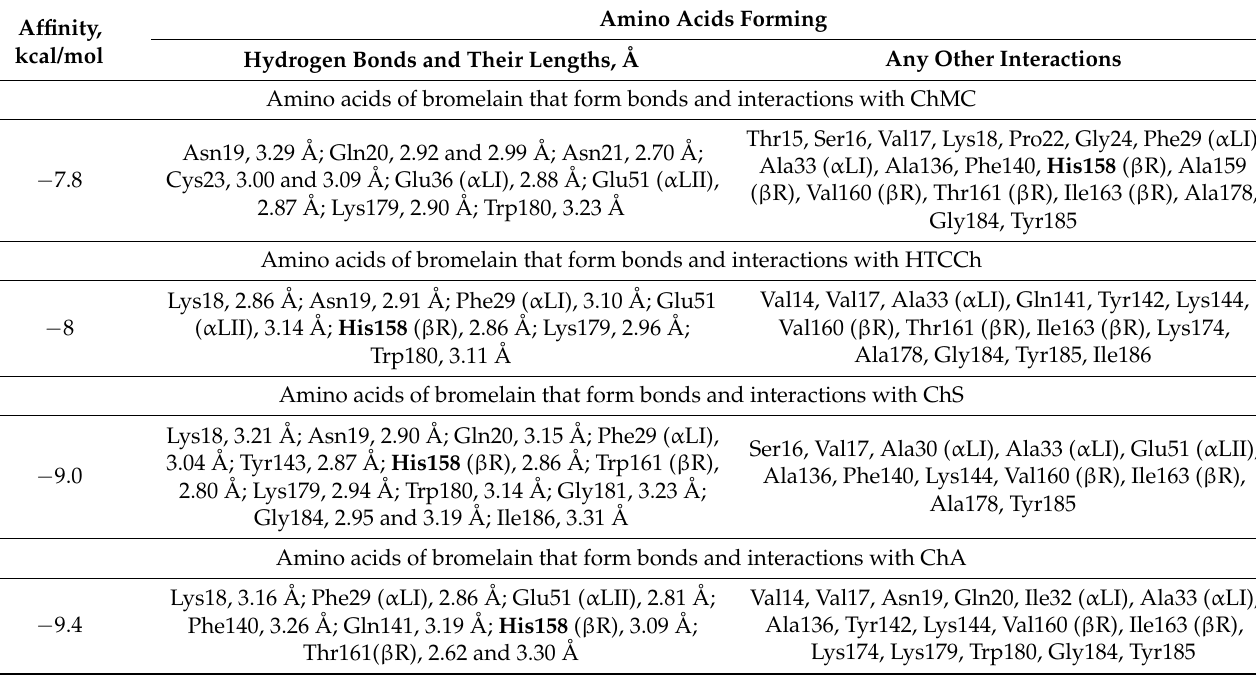
Table 1. Bromelain amino acids interacting with ligands *.